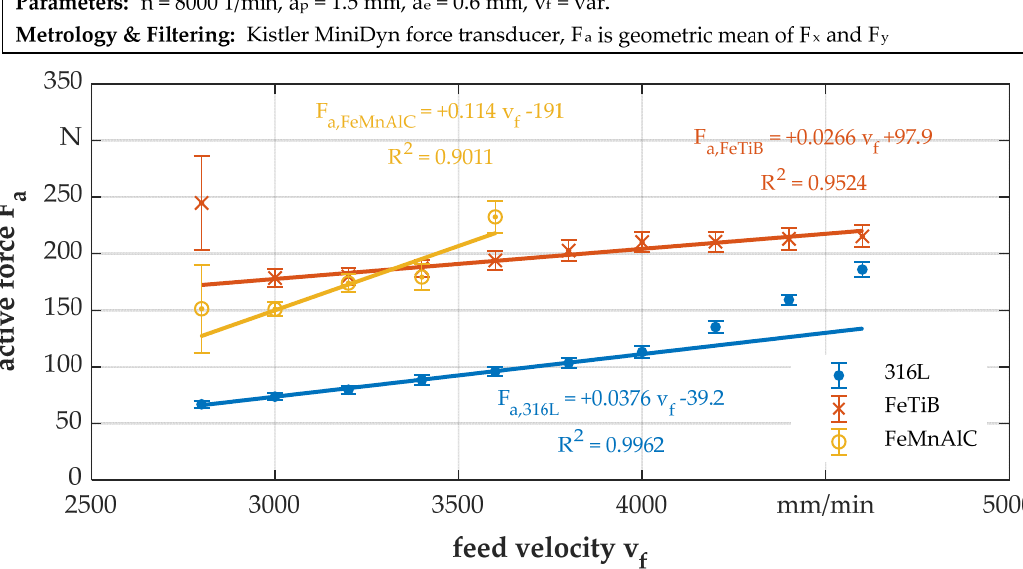
Figure 5. Feed velocity dependent active cutting force; force values are the weighted mean of F a for three experiments, error bars indicate the error of the mean as the maximum of the internal (error within each measurement) and external (error across the repetitions) error.